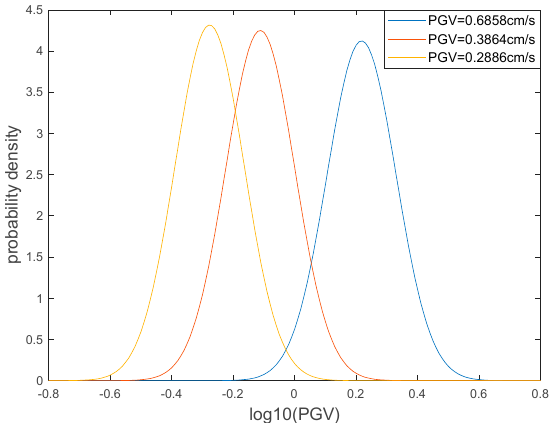
Figure 3. Probability density distribution of different lgPGVs.